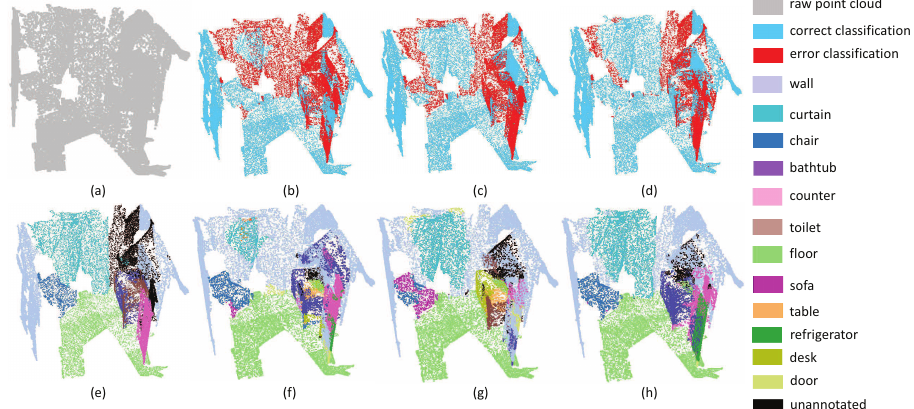
Figure 6. The plane segmentation results on Bedroom . ( a ) input, ( e ) ground truth, ( b , f ) the classification result by PointNet++, ( c , g ) the classification result by PointSIFT, and ( d , h ) the classification result by